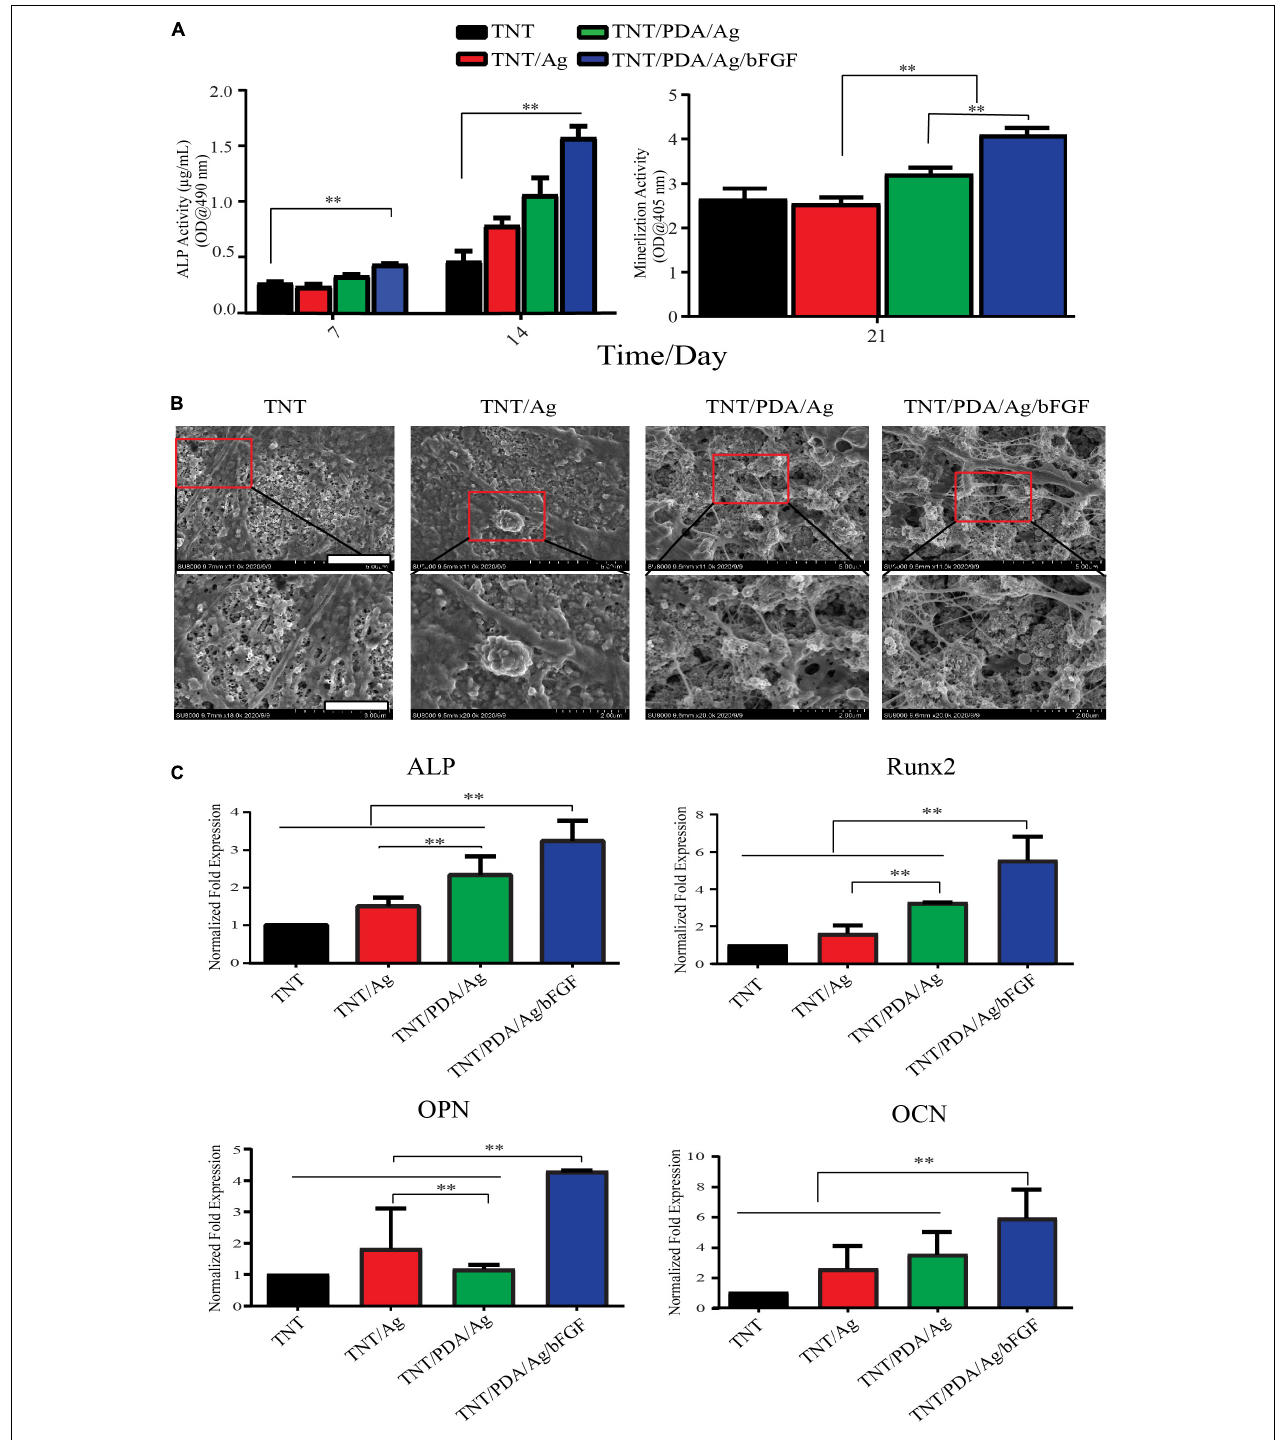
FIGURE 6 | Osteogenic differentiation of DPSCs on modified Ti samples. (A) ALP activity of DPSCs cultured on TNT/PDA/Ag/bFGF was significantly higher than that on other surfaces on days 7 and 14. Mineralization assay stained with Alizarin red S indicated that DPSCs grown on TNT/PDA/Ag/bFGF showed the highest calcium deposition among all surfaces. (B) After 21-day culture of DPSCs on sample surfaces, cells were prepared and examined by SEM. Calcium deposition on TNT/PDA/Ag/bFGF was significantly higher in all surfaces. Scale bars represent 5 and 2 µ m in the upper and lower panels, respectively. (C) Relative mRNA expression of osteogenic genes (ALP, OPN, RUNX, and OCN) were normalized to GAPDH and compared among all groups. Osteogenic gene expression of DPSCs cultured on TNT/PDA/Ag/bFGF was the highest. Data are presented as mean ± standard deviation; ∗∗ p < 0.01. DPSCs, dental pulp stem cells; ALP, alkaline phosphatase; OPN, osteopontin; RUNX, runt-related transcription factor 2; OCN, osteocalcin.